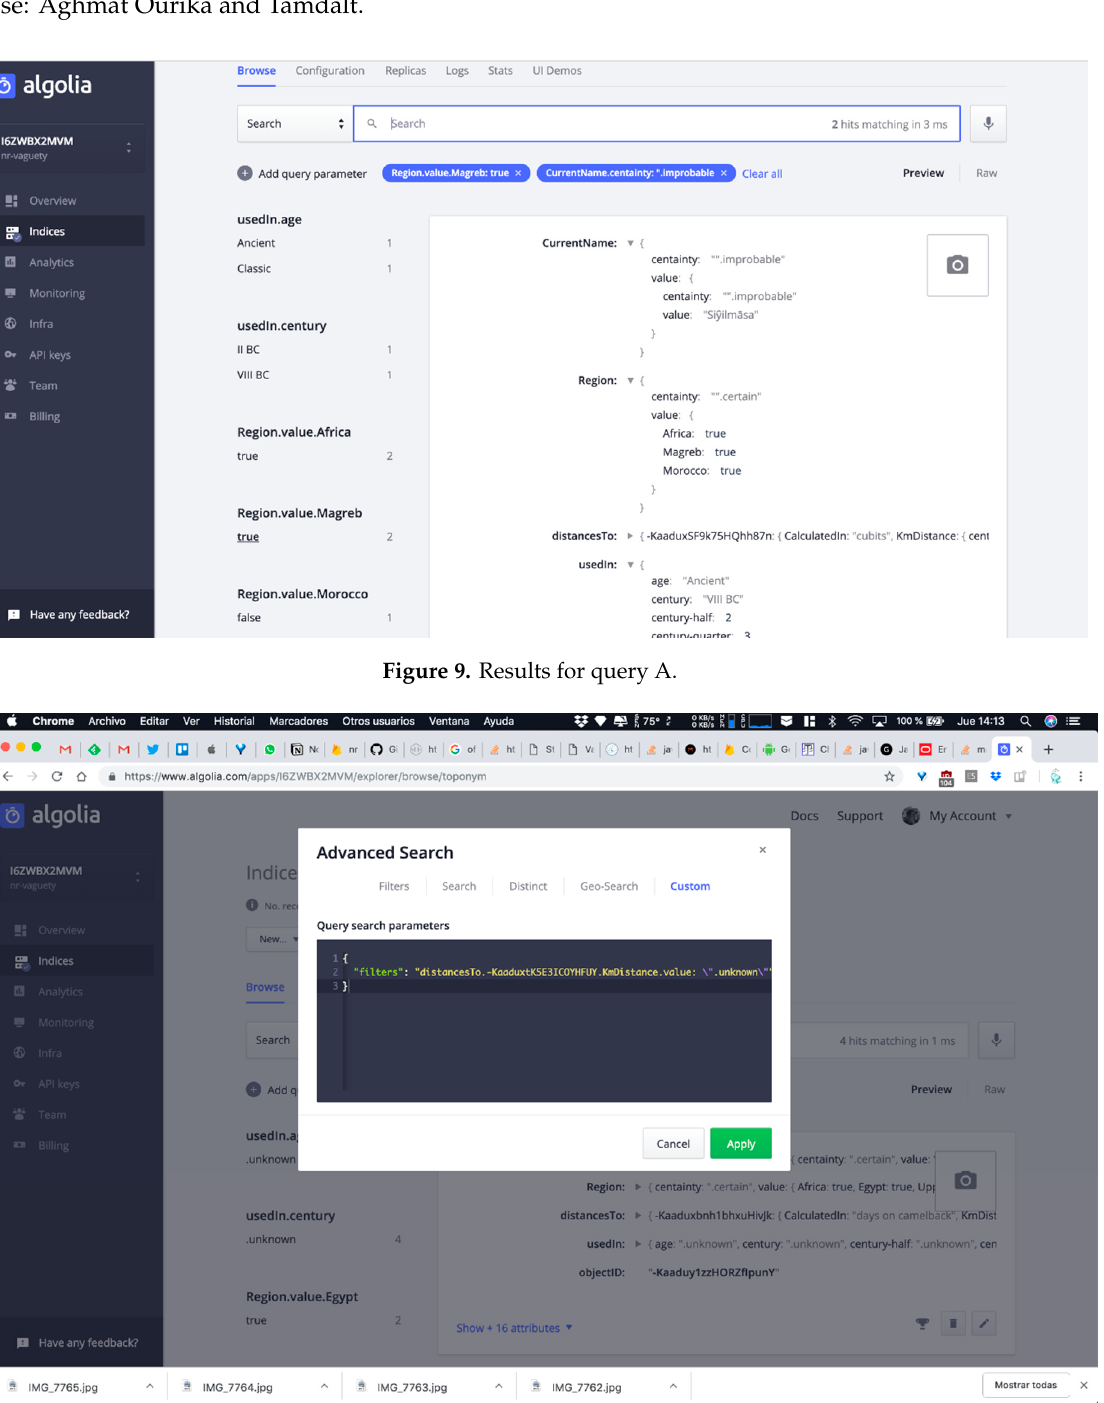
Figure 10. Query B execution using Algolia search engine. We have added custom expression on